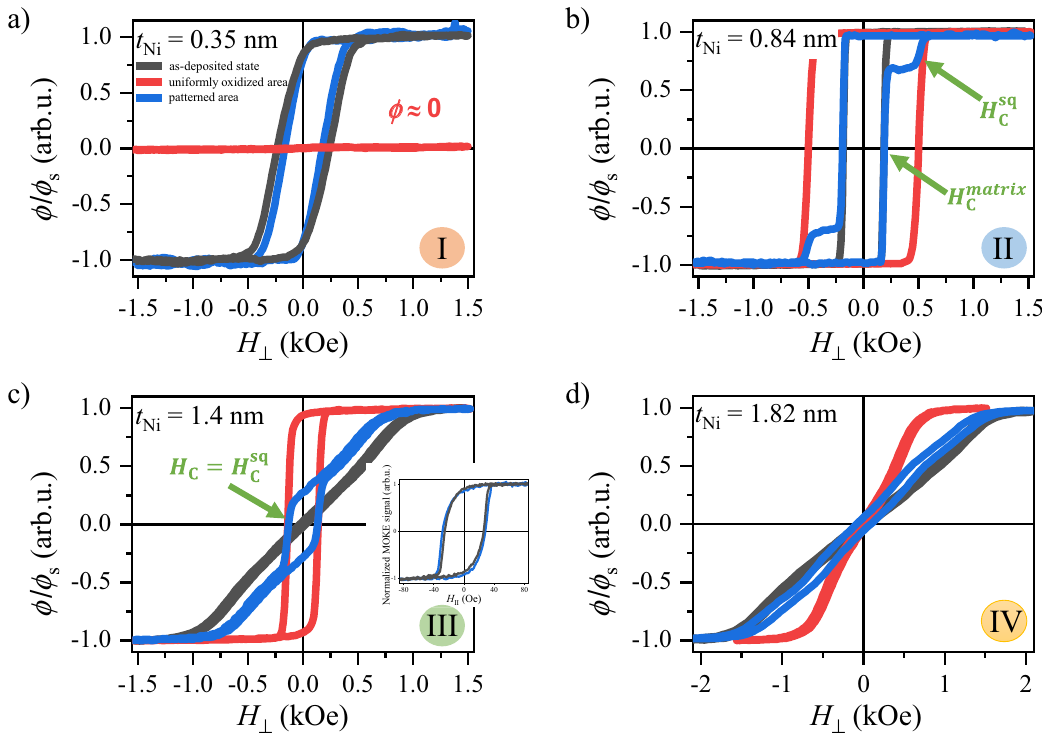
Figure 4. Representative normalized ϕ / ϕ s P-MOKE hysteresis loops for the buffer/Co 1.4 nm/Ni- t Ni (wedge 0–3 nm) system ( a ) t Ni = 0.35, ( b ) t Ni = 0.84, ( c ) t Ni = 1.4, ( d ) t Ni = 1.82 nm. Colors of hysteresis denote the states of the sample: black (matrix)—sample in the as-deposited state; red (uniformly oxidized area)—sample after plasma oxidation with τ Ox = 110 s; blue (patterned area)—matrix is protected by the photoresist maintaining its original state, and squares are exposure to plasma. Inset in ( c ) shows the hysteresis loops determined from Kerr microscopy images with in-plane sensitivity for t Ni = 1.4 nm for as-deposited and protected areas (matrix). The numbers in the circles correspond to specific t Ni ranges in Fig.